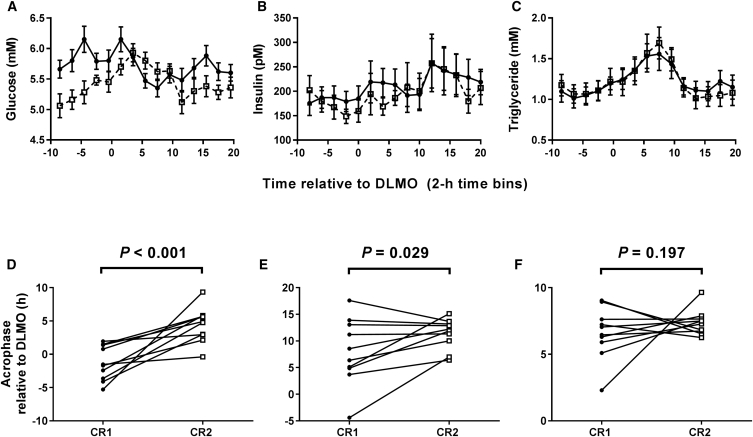
A 5-hr Delay in Meal Times Delays the Plasma Glucose Circadian Rhythm(A–C) Concentration of glucose (A), insulin (B), and triglyceride (C) in 2-hourly plasma samples collected in constant routine conditions. Data are plotted as mean ± SEM. Black circles with solid lines represent data following early meals (0.5, 5.5, and 10.5 hr after waking up). White squares with dashed lines represent data following a 5-hr delay in each meal.(A) There were significant effects of time (F(14,126) = 3.71, p < 0.001), meals (F(1, 9) = 29.84, p < 0.001), and meal × time interaction (F(14,126) = 5.10, p < 0.001) on glucose concentration.(B) There was a significant effect of time (F(14,126) = 2.79, p = 0.001), but no significant effect of meals (F(1, 9) = 4.69, p = 0.059) or meal × time interaction (F(14,126) = 1.16, p = 0.312) on plasma insulin concentration.(C) There was a significant effect of time (F(14,126) = 18.44, p < 0.001), but no significant effect of meals (F(1, 9) = 0.01, p = 0.913) or meal × time interaction (F(14,126) = 1.19, p = 0.294) on plasma triglyceride concentration.(D–F) Acrophase of glucose (D), insulin (E), and triglyceride (F) rhythms in individuals following early meals (constant routine 1, CR1; black circles) and following a 5-hr delay in meal time (constant routine 2, CR2; white squares). Using a paired t test, there was a significant effect of meal timing on glucose phase (delay of 5.59 ± 1.29 hr; t(9) = 4.415, p < 0.001), but not on the phase of insulin (t(9) = 2.179, p = 0.029; note Bonferroni-corrected critical p value below) or triglyceride (t(9) = 0.896, p = 0.197).(A–F) Data are from n = 10 participants, calculated relative to each individual’s dim light melatonin onset (DLMO). Statistical significance is defined as p < 0.01 (following Bonferroni correction for analysis of a total of five rhythmic plasma markers).